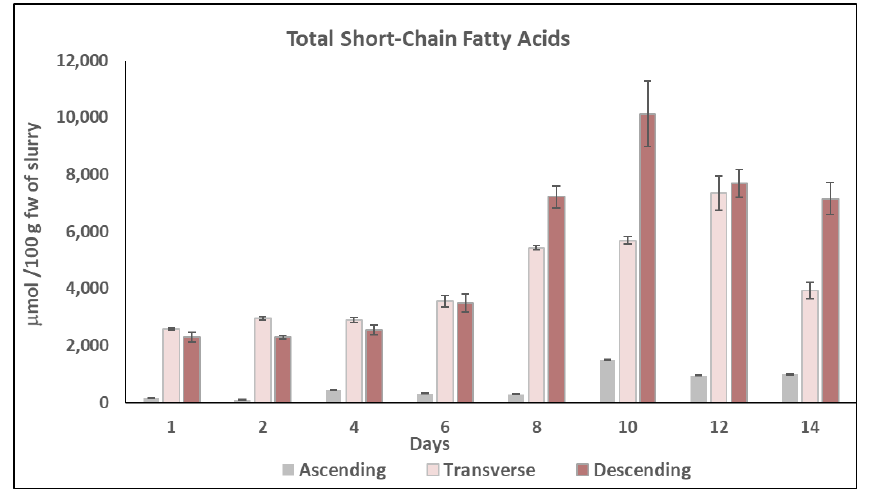
Figure 7. Total concentration (µmol/100 g fw of slurry) of short-chain fatty acids (SCFAs) in the ascending colon (AC), transverse colon (TC), and descending colon (DC) during the colonic fer- mentation of HPP-treated onion. Data are the mean values ± standard deviation of three different determinations ( n = 3).